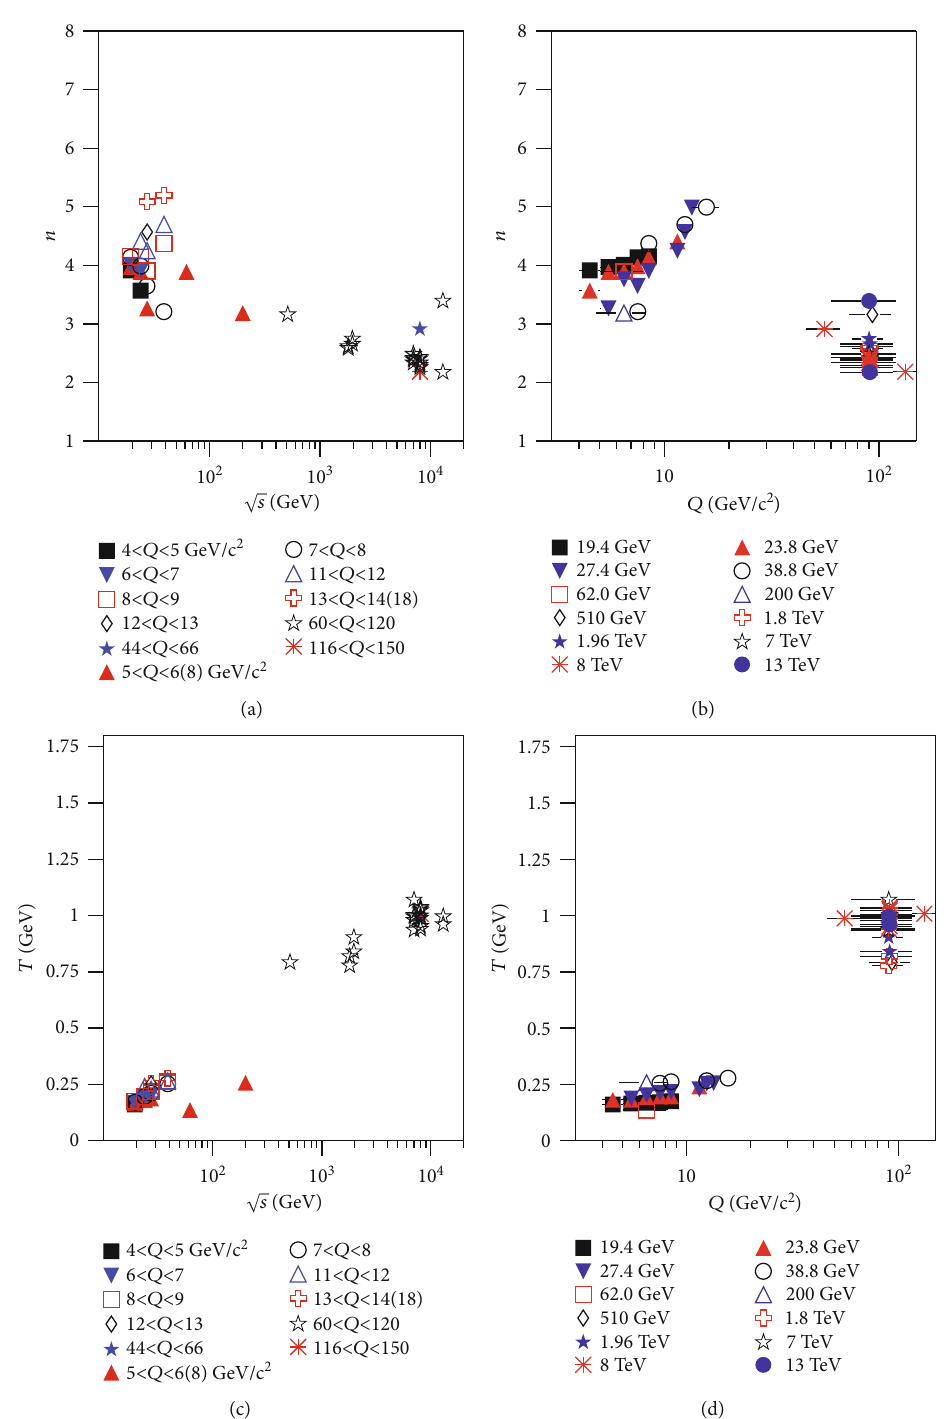
ffiffi p s (a, c) and invariant mass Q (b, d). The